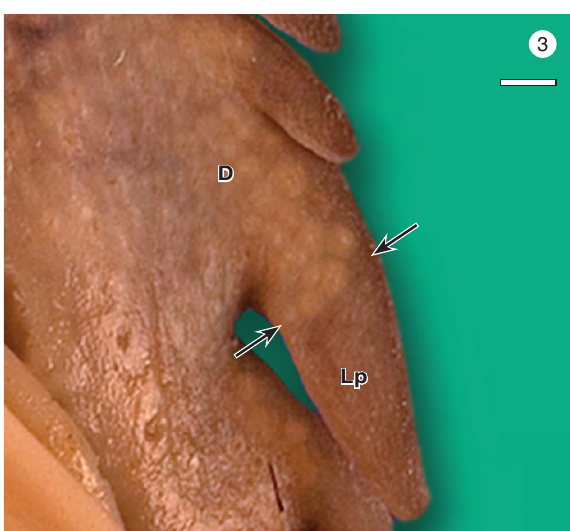
FIG. 3 Ventral view of the lateral lingual papillae showing the abrupt transition (arrows) between the presence of dough­ nut­shaped structures (D) and the unelaborated surface of the papillae (Lp). Bar = 1